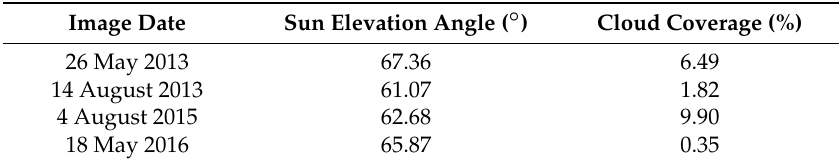
Table 2. Information of the Landsat OLI imagery used in this